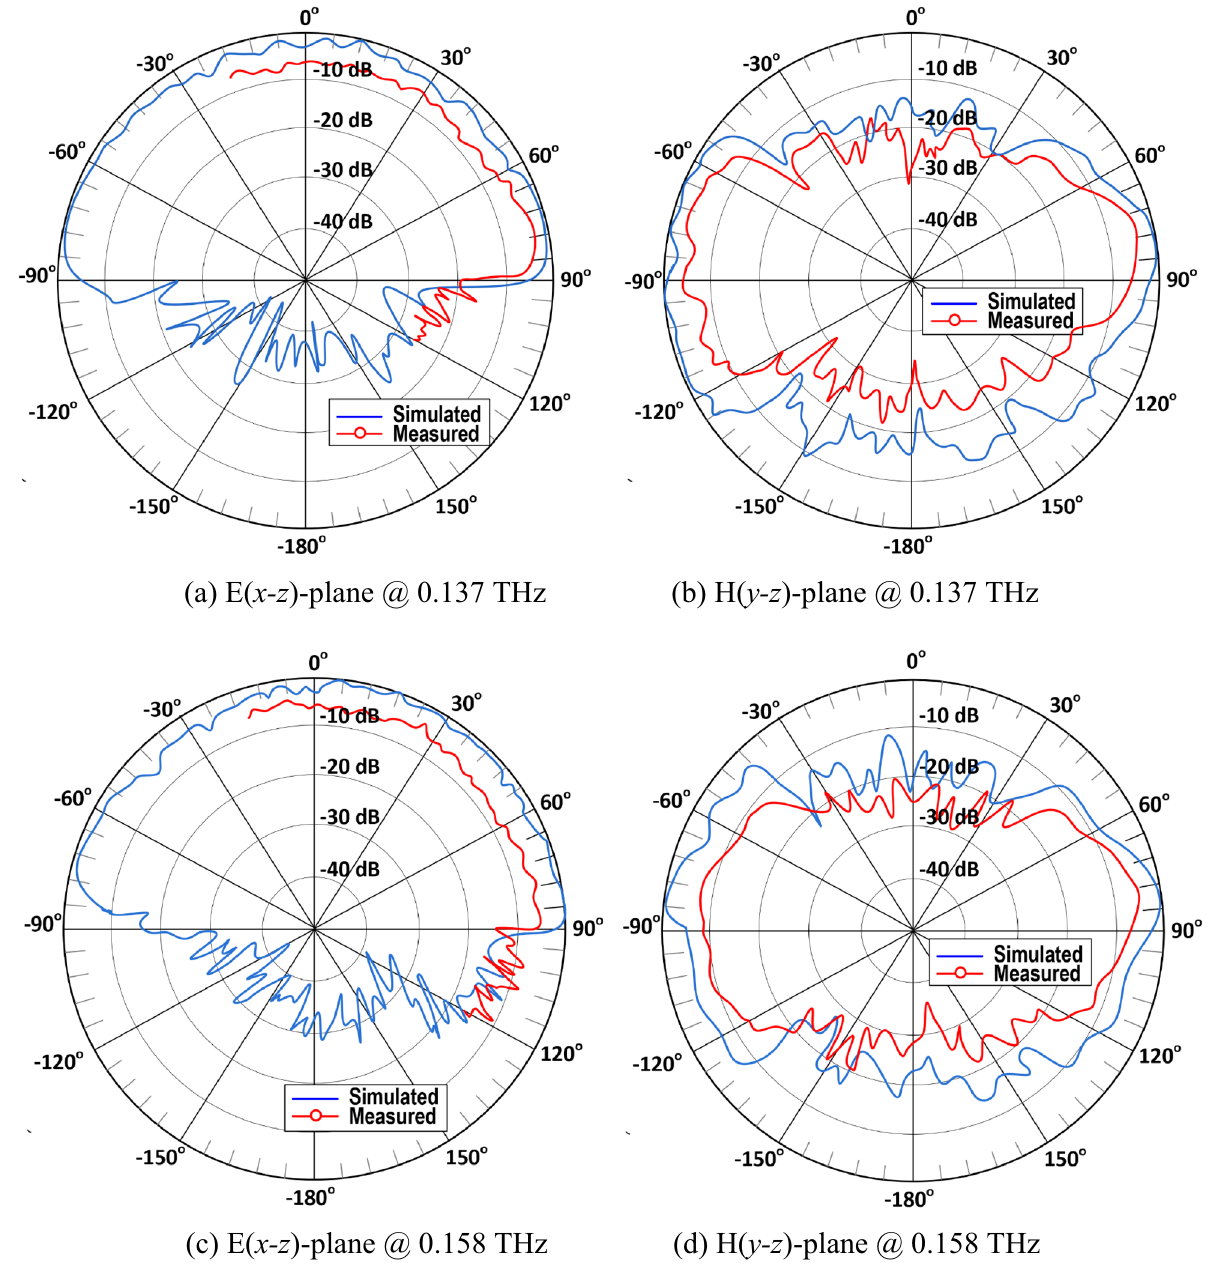
Figure 6. Normalized simulated and measured radiation patterns in the E-plane and H-plane of the proposed OCA with the MTM-IMC termination and